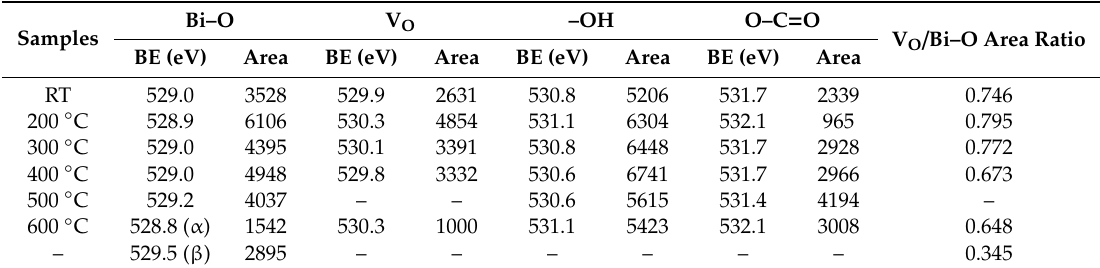
Figure 15. High-resolution XPS spectra of O 1s for Bi 2 O 3 :Ho 3 + thin films deposited at di ff erent substrate Figure 15. High ‐ resolution XPS spectra of O 1s for Bi 2 O 3 :Ho 3+ thin films deposited at different temperatures: ( a ) RT, ( b ) 200 ◦ C ( c ) 300 ◦ C, ( d ) 400 ◦ C, ( e ) 500 ◦ C and ( f ) 600 ◦ C. Table 5. O 1s peak positions and peak areas of the Bi 2 O 3 :Ho 3 + thin films deposited at di ff erent Table 5. O 1s peak positions and peak areas of the Bi 2 O 3 :Ho 3+ thin films deposited at different substrate substrate temperatures.